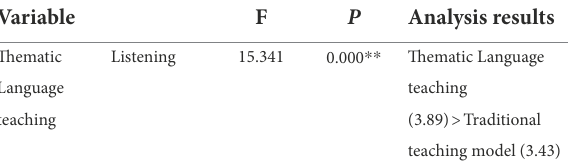
TABLE 1 Difference analysis of thematic language teaching in listening. Variable